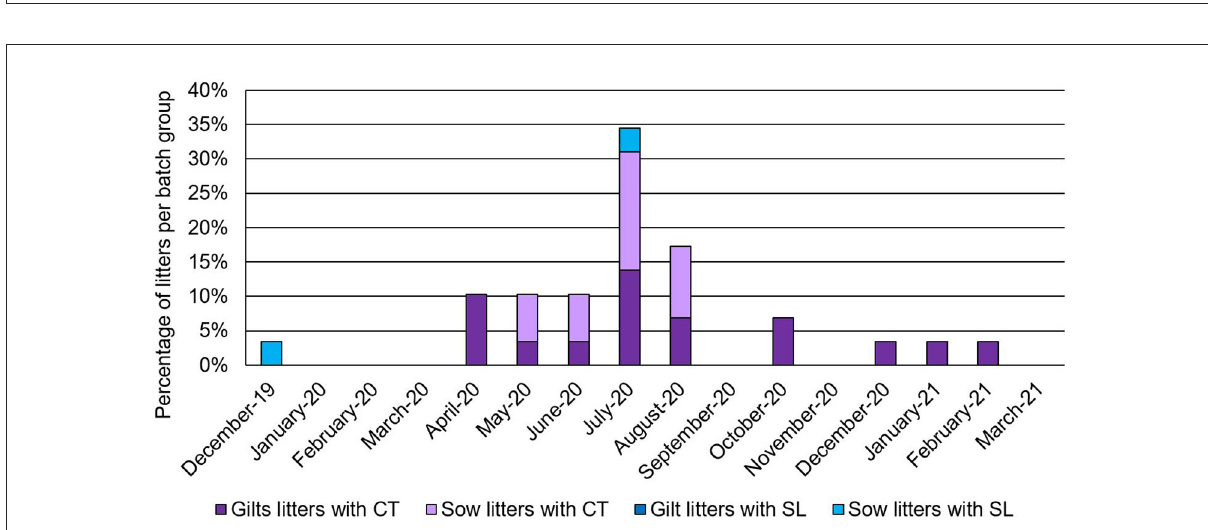
FIGURE2 Percentage of litters from a farrowing batch group with clinical signs of congenital tremors (CT) or splay leg (SL) then break down of the litters with clinical cases based on parity (females considered a gilt if this was their first litter farrowed, all other females considered sows). Date is designated as